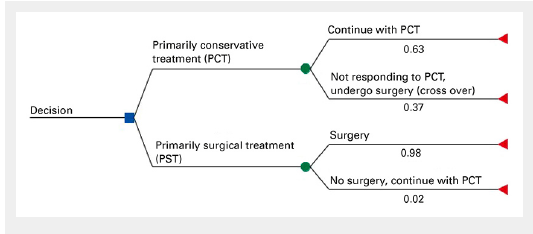
Decision analysis tree comparing primarily conservative treatment (PCT) with primarily surgical treatment (PST)